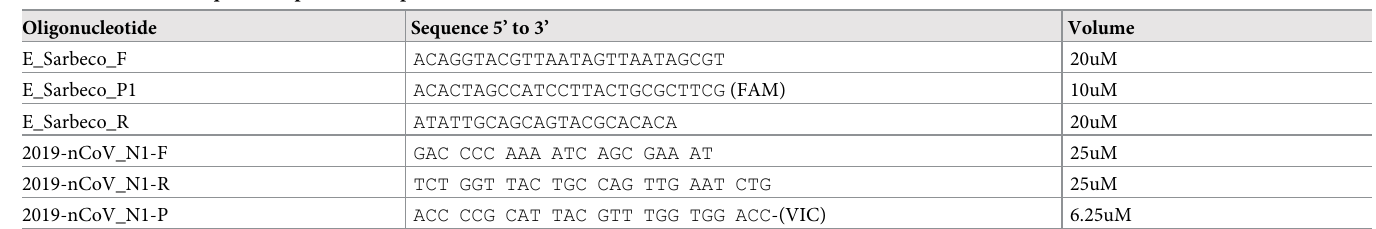
Table 1. SARS-CoV-2 qRT-PCR primers and